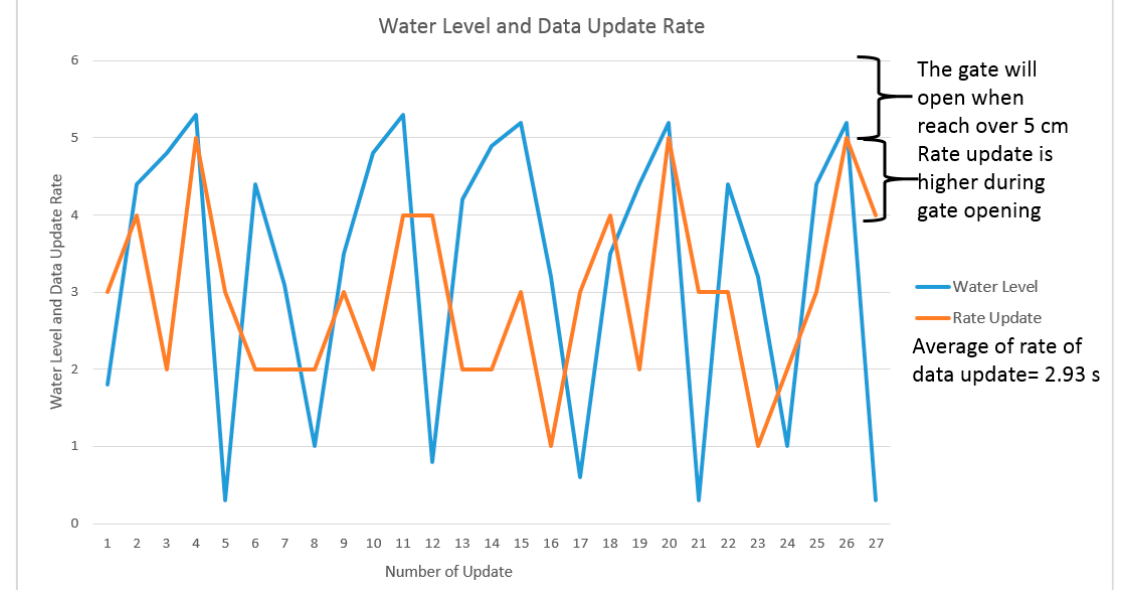
Figure 18. Gate V2 water level and data update rate.